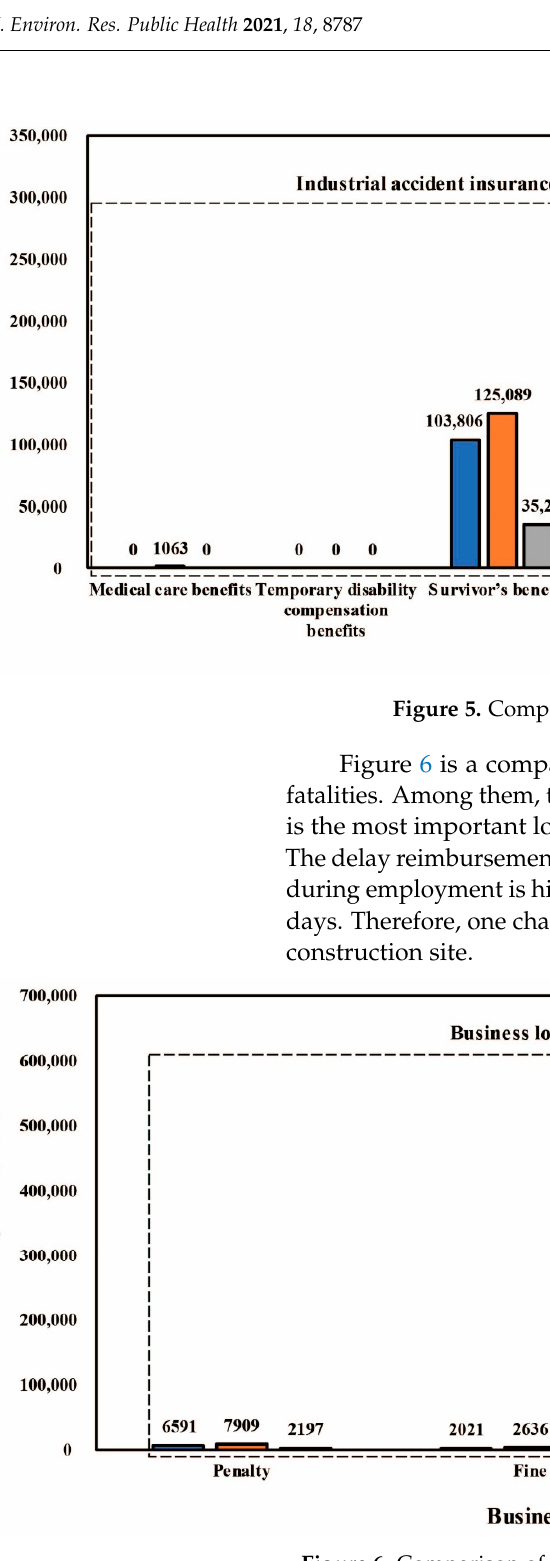
Figure 6. Comparison of business and administrative loss